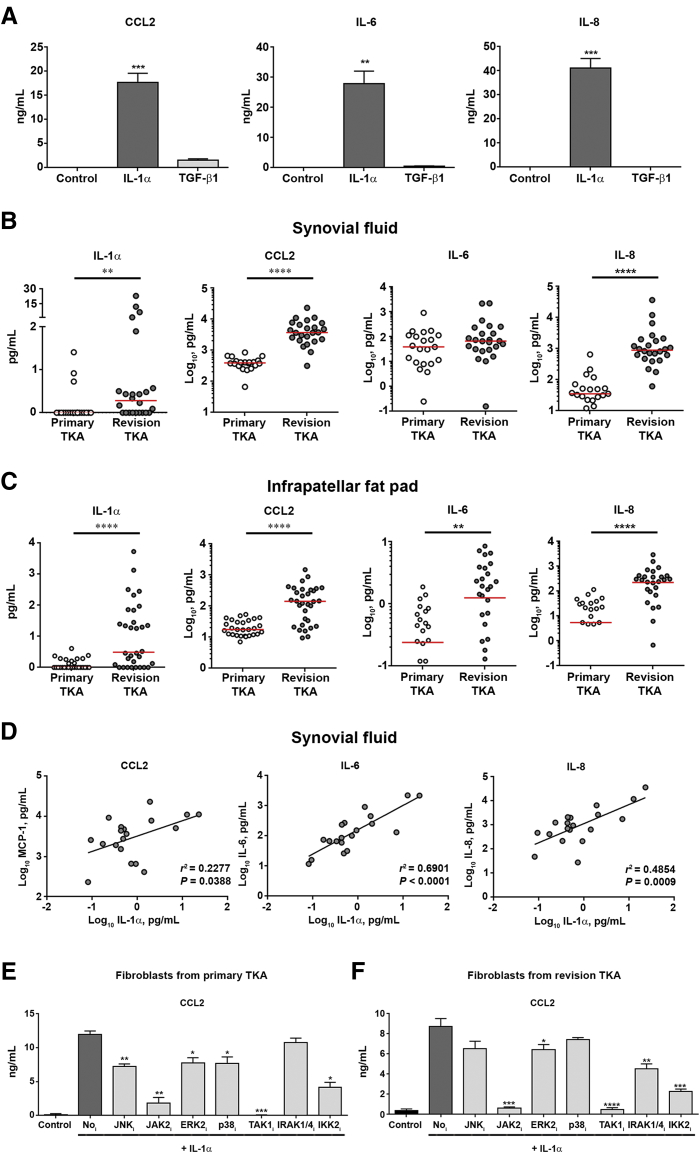
Markers elevated after total knee arthroplasty (TKA) are associated with fibroblast activation. A: Fibroblasts isolated from the infrapatellar fat pad of patients undergoing primary TKA were treated with control media, IL-1α (500 pg/mL), or transforming growth factor (TGF)-β1 (3 ng/mL) for 24 hours and secreted levels of CCL2, IL-6, and IL-8, determined by enzyme-linked immunosorbent assay (ELISA). Data are analyzed using paired t-tests. B and C: IL-1α, CCL2, IL-6, and IL-8 protein levels were quantified in synovial fluid (B) and infrapatellar fat pad (C) and compared between patients undergoing primary and revision TKA. Data are presented as individual patient values, with median signified by the red line and analyzed using a U-test. D: IL-1α protein expression correlates against CCL2, IL-6, and IL-8 levels in synovial fluid. Data are presented as individual patient values with associated linear regression analysis. E and F: Fibroblasts isolated from the infrapatellar fat pad of patients undergoing primary (E) and revision (F) TKA were pretreated for 1 hour with several selective inhibitors [TAK1 inhibitor (TAKi), 1 μmol/L; all other inhibitors, 10 μmol/L] before stimulation with IL-1α (500 pg/mL) for 24 hours, and CCL2 was quantified by ELISA. Data are analyzed using paired t-tests. Data are presented as means ± SEM (A, E, and F). n = 6 (A, E, and F). ∗P < 0.05, ∗∗P < 0.01, ∗∗∗P < 0.001, and ∗∗∗∗P < 0.0001 primary versus revision patients. ERK, extracellular signal–regulated kinase; IKK, Iκ B kinase; IRAK, IL-1 receptor associated kinase; JAK, Janus activating kinase; JNK, c-Jun N-terminal kinase; MCP, monocyte chemoattractant protein.